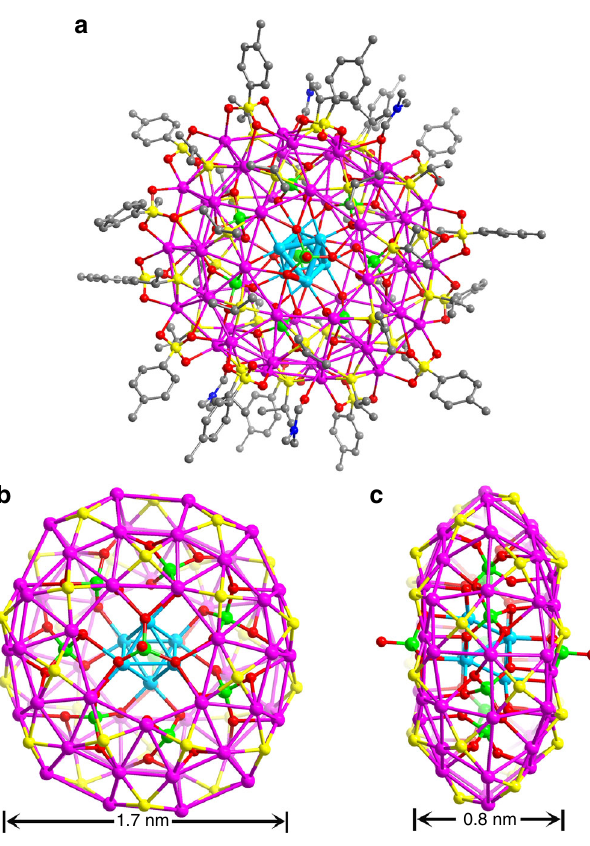
Fig. 2 Single-crystal structure of SD/Ag7 . a The total structure of SD/Ag7 showed in ball-and-stick model. Ball-and-stick model of SD/Ag7 showing the front ( b ) and side ( c ) views with all C atoms omitted for clarity. (Colour legend: purple, Ag on the shell; cyan, Ag in the kernel; yellow, S; red, O; green,